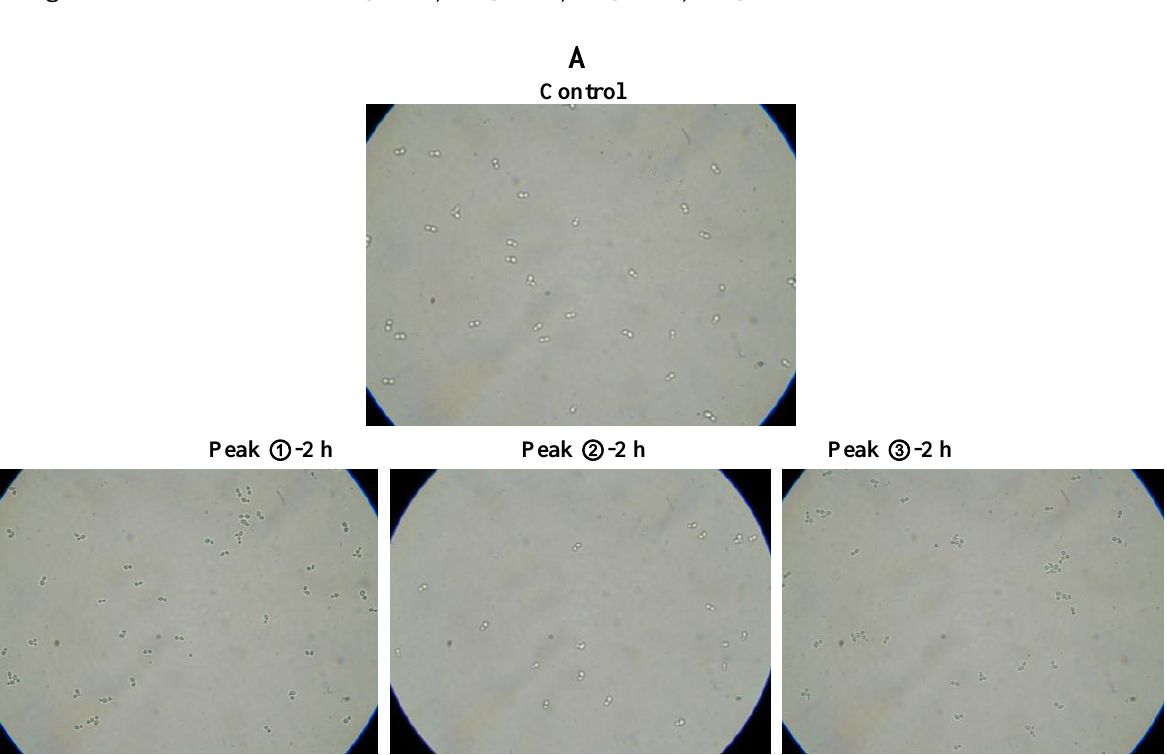
Figure 2. Antifungal activity of the purified peptides digested with 1 N HCl against C. albicans ( A ). Antifungal activity of purified peptides against C. albicans . Yeast cells were suspended at density of approximately 2 × 10 3 /mL in YPD. Dilutions of the peptide were added, and reaction mixture was incubated for 2, 4, 8 and 24 h at 30 °C. Top row: C. albicans cells not treated with the purified peptides. Antifungal activity of the second peak (Potide-J) aganist C. albicans . ( B ) a : ② -2 h, b : ② -4 h, c : ② -8 h, d : ② -24